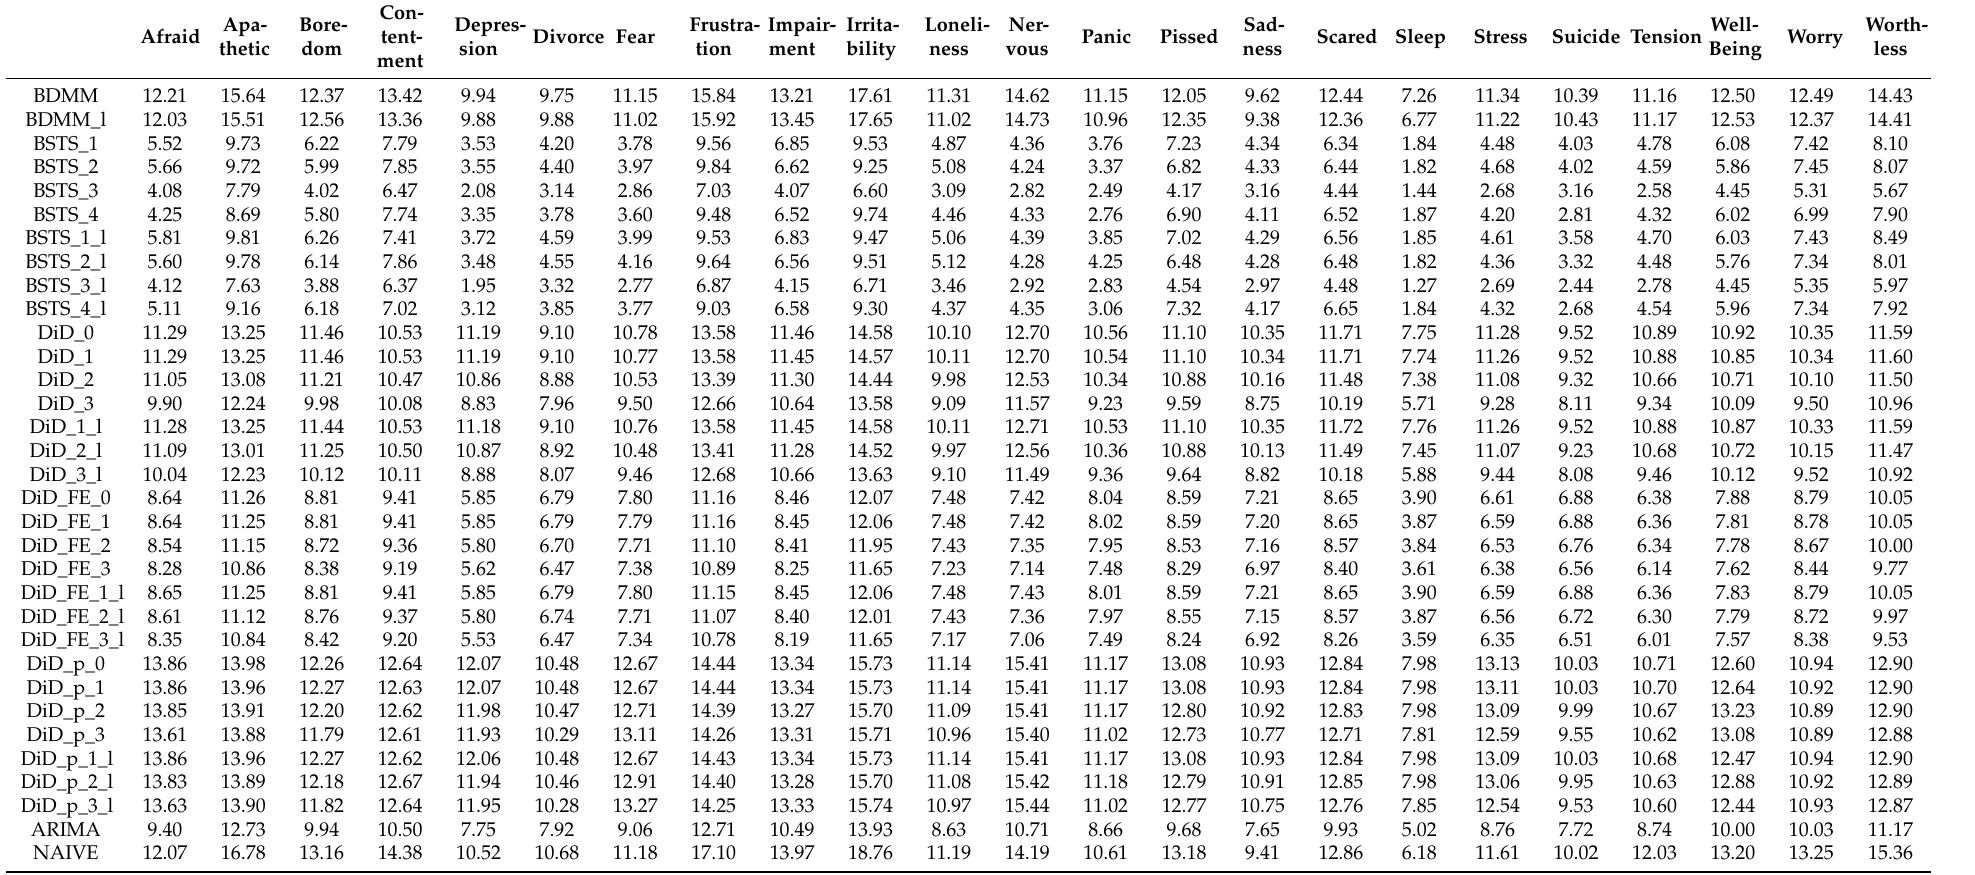
Table 4. Average values of RMSE over the